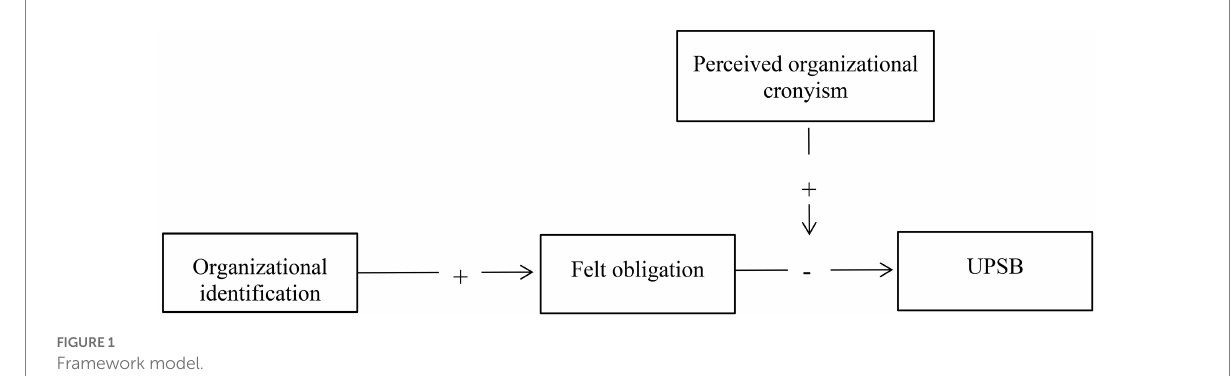
FIGURE 1 Framework